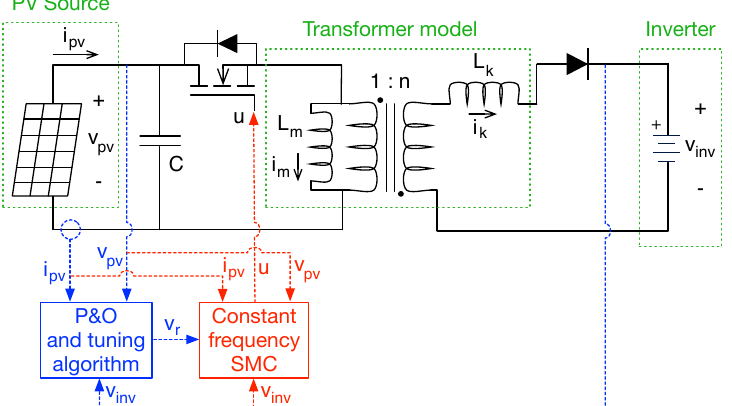
Figure 2. Flyback-based PV system with P&O, tuning algorithm and fixed-frequency